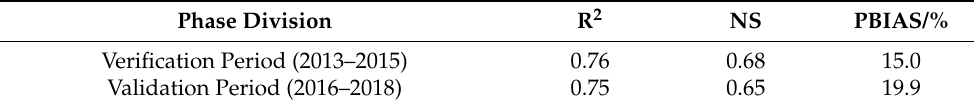
Figure 3. Comparison of measured and simulated monthly runoff. Table 3. Calibration results of SWAT surface runoff simulation based on measured data.